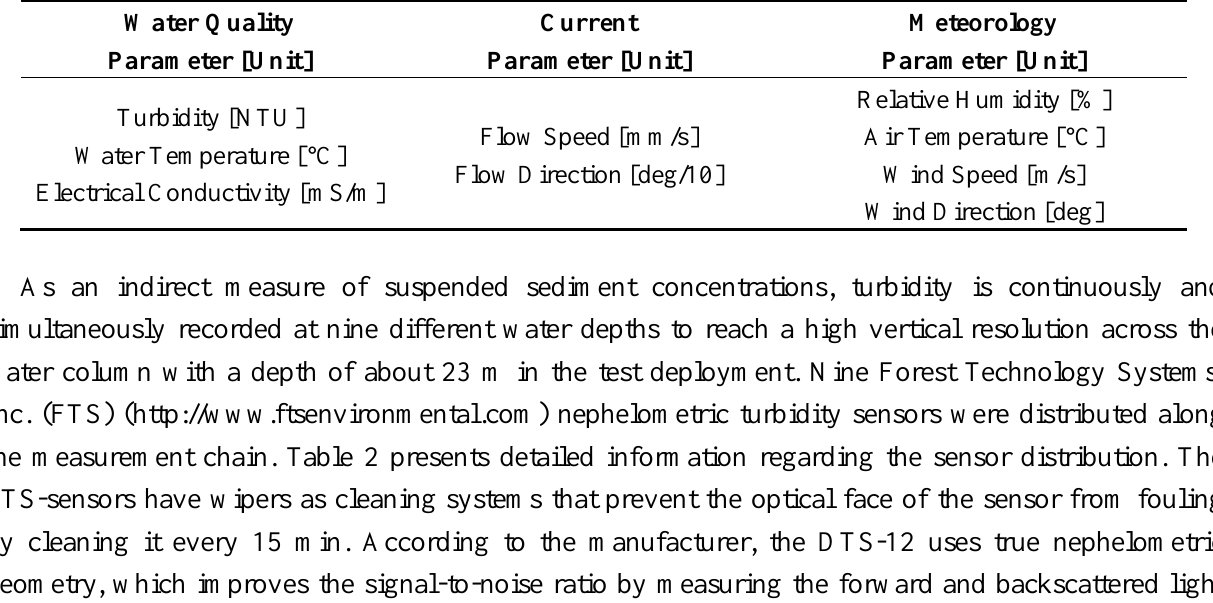
Table 1. Measured parameters of the buoy